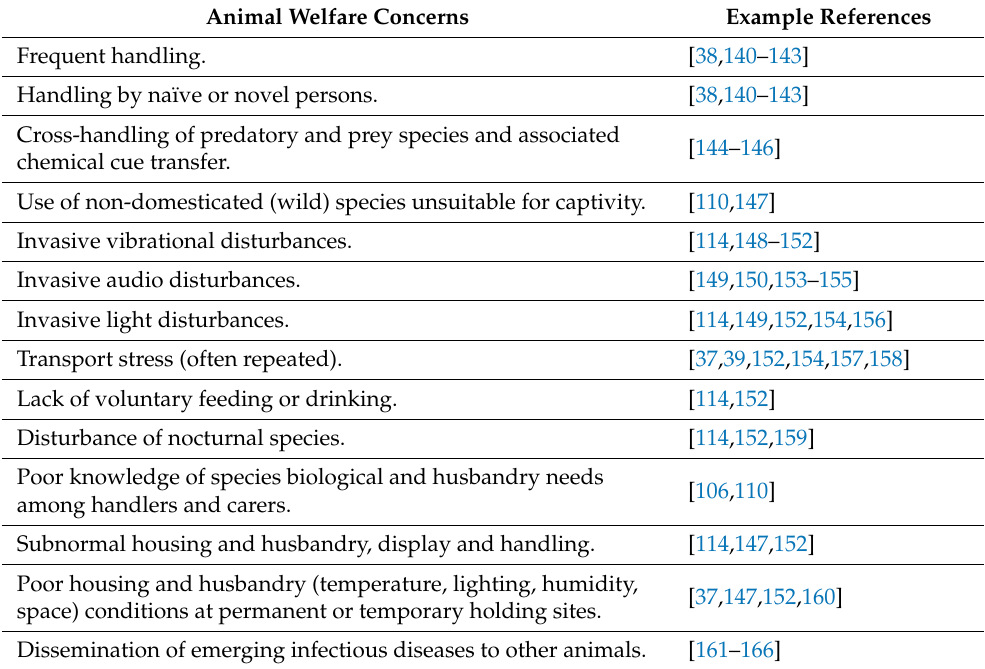
Table 10. Animal welfare concerns identified in peer-reviewed literature that are relevant to mobile zoo